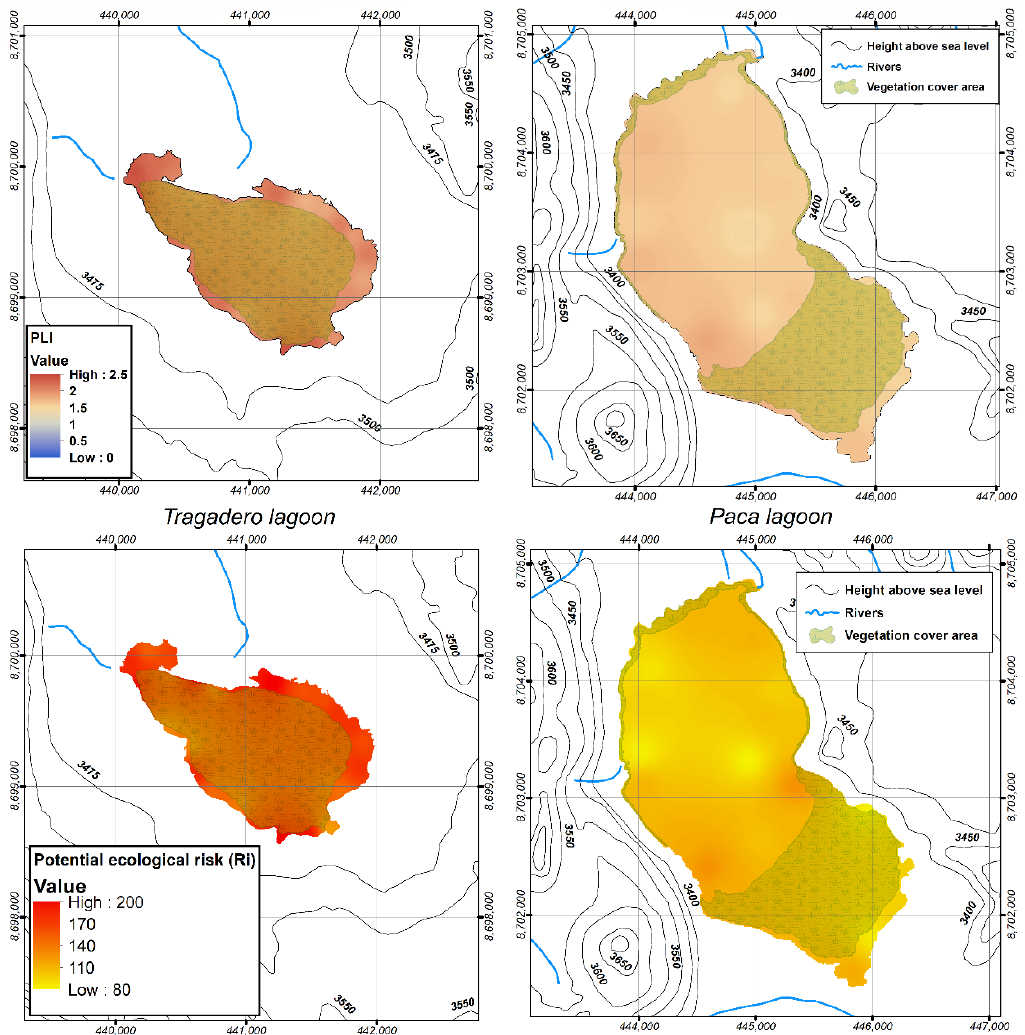
Figure 4. Contamination load index (PLI) and potential ecological risk (Ri) of heavy metals in sediments of the Tragadero and Paca lagoons.